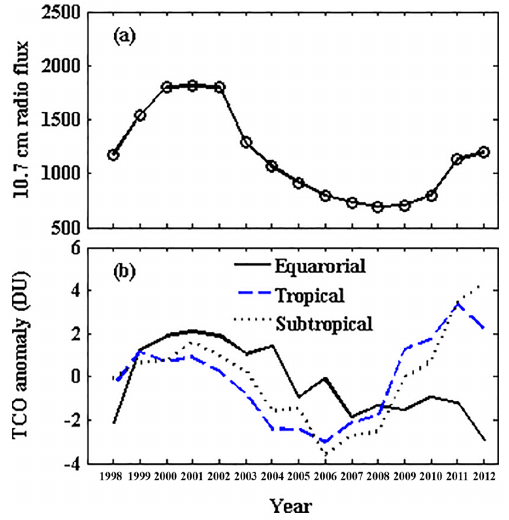
Figure 9. (a) Annual mean of 11-year solar flux recorded from 1998 to 2012 and (b) the annual TCO anomaly recorded for the same period in equatorial, tropical and subtropical